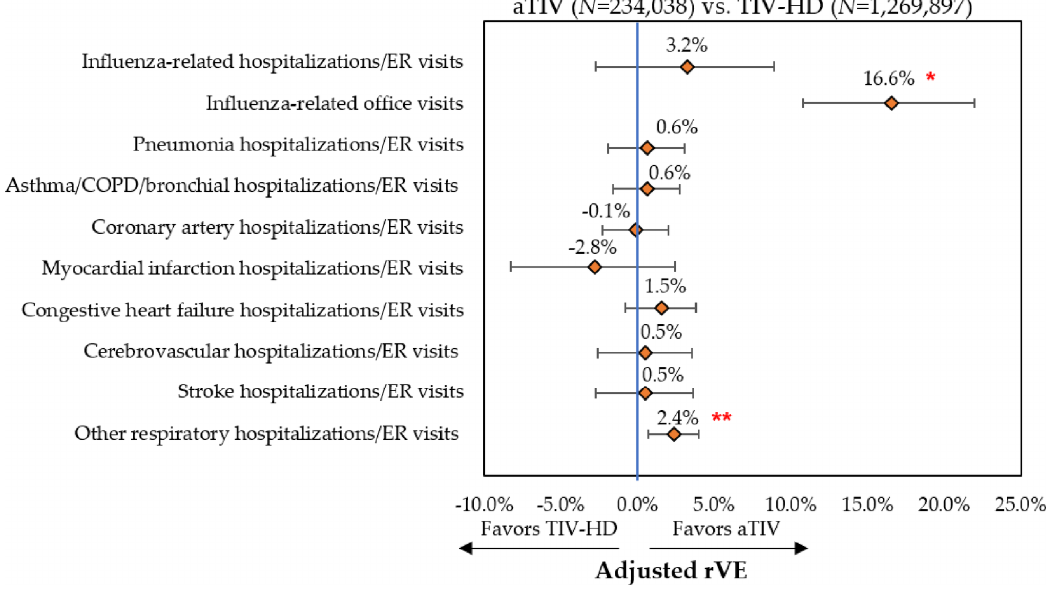
Figure 5. Adjusted relative vaccine effectiveness (rVE) — post-IPTW and Poisson regression — aTIV vs. TIV-HD. * p < 0.001; ** p < 0.01; rVE = relative vaccine effectiveness.